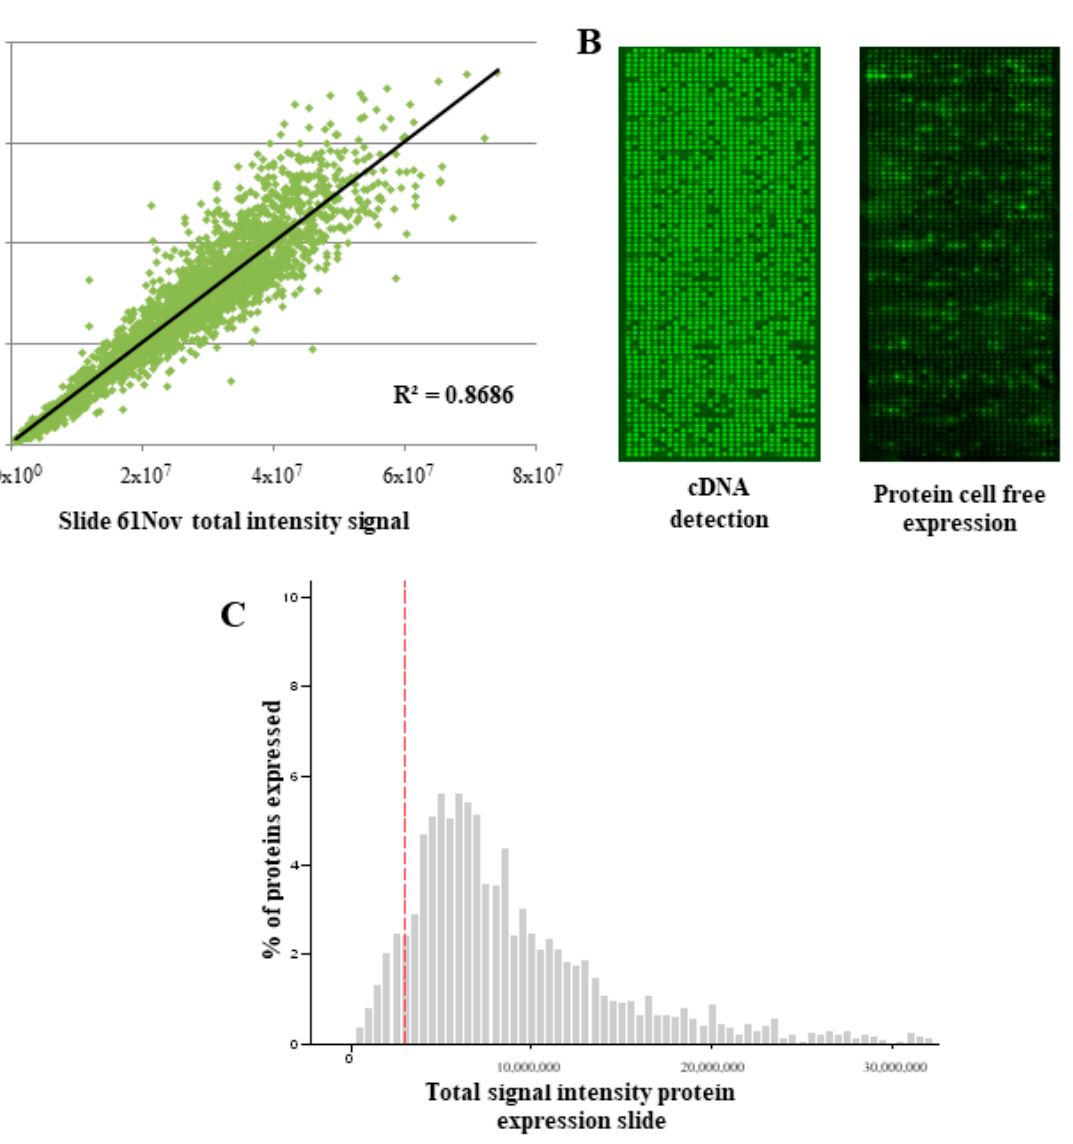
Figure 1. Overall performance of customized NAPPArray. ( A ) displays scatter plot of raw data (total signal intensity) correlation of two different arrays of cDNA stained assessment that illustrate the reproducibility of assays. ( B ) corresponds to high-density NAPPArray displaying 2164 antigenic tumoral proteins included in this study. cDNA stained at described in Section 2; IVTT protein cell-free expression was detected by the α -GST monoclonal antibody. ( C ) shows the relationship between cDNA and protein expressed in NAPPArray platform represented by the histogram of expression total signal intensity and the cell-free protein expression frequency, the red line corresponds to the median of total intensity values of negative controls (nonspot) + 2SD.